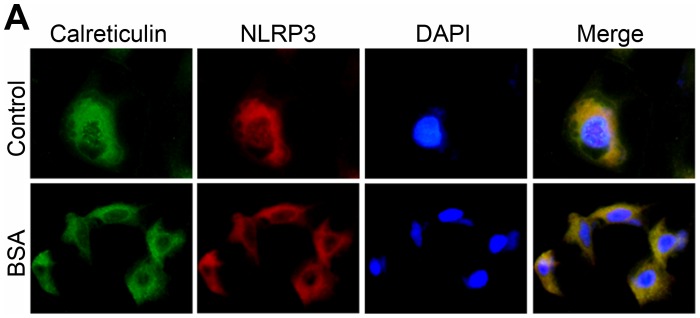
The NLRP3 protein overlaps with the ER marker calreticulin in NRK-52E cells.Growth arrested NRK-52E cells were treated without (upper line) or with 5 mg/ml BSA (under line) for 24 hours in serum-free medium. NLRP3 protein (red) and calreticulin protein (green) were detected by an indirect immunofluorescence staining.